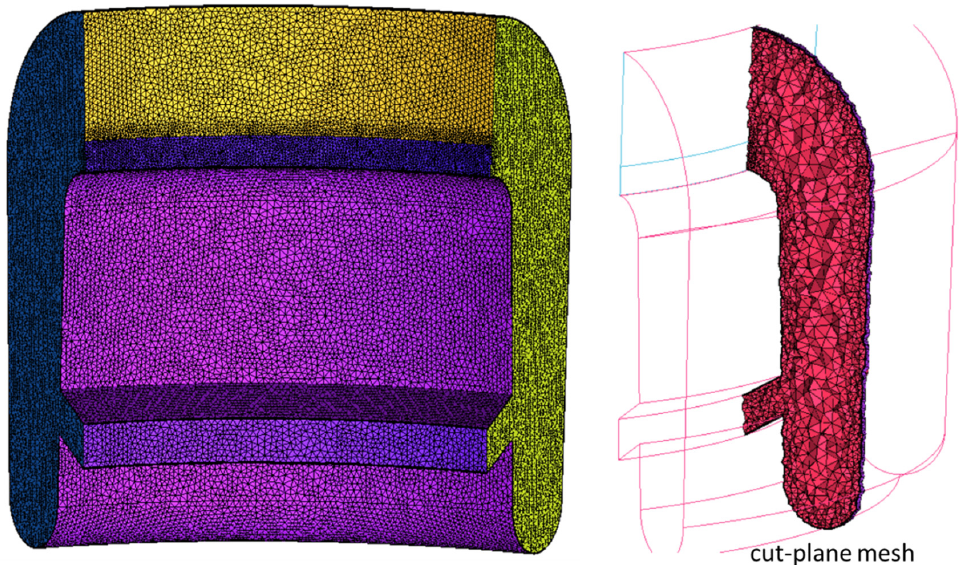
Figure 3. Mesh of a sector of the ported shroud with a cut-plane.